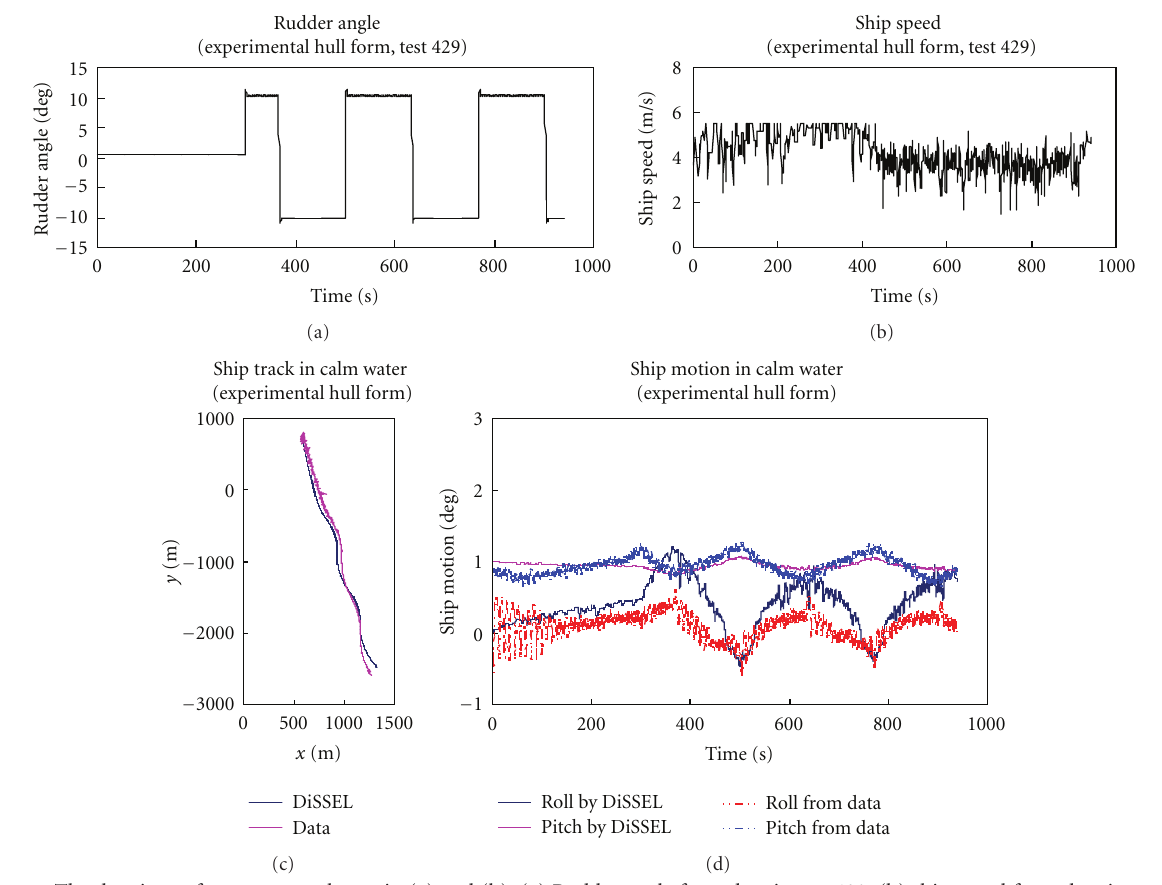
Figure 5: The data input for case 5 are shown in (a) and (b). (a) Rudder angle from data in test 429, (b) ship speed from data in test 429. Benchmark simulations for case 5 are shown in (c) and (d). (c) Comparison of ship track between simulation and experimental data in test 429. (d) Comparison of roll and pitch motions between simulation and experimental data in test